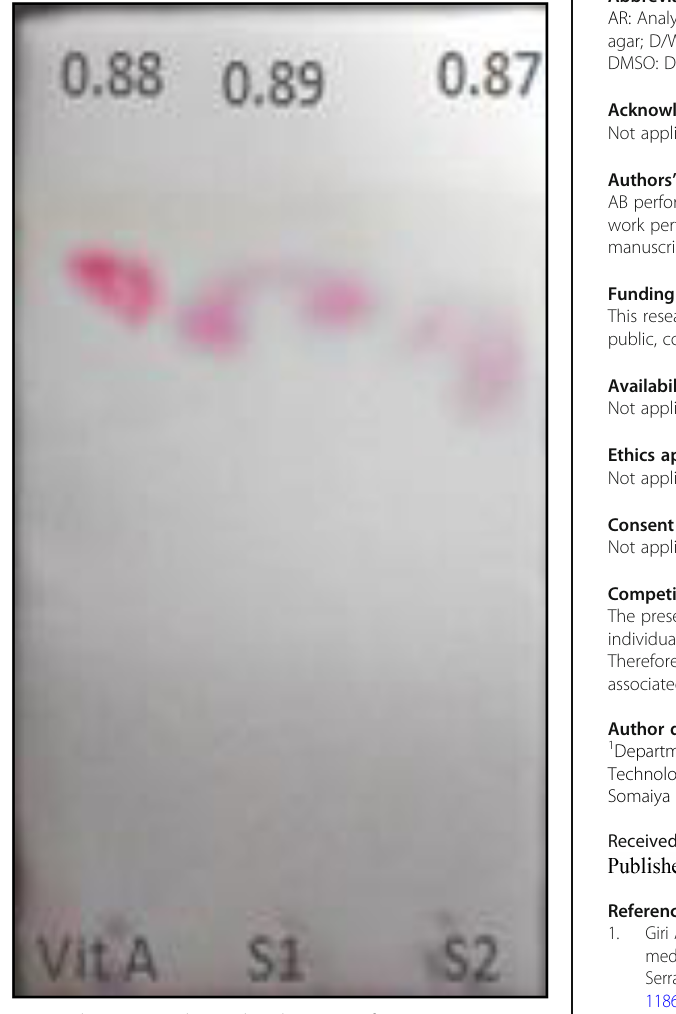
Fig. 12 Chromatographic analysis by TLC. (Reference; vitamin A, S1; sample of methanolic extract of prodigiosin, S2; DMSO